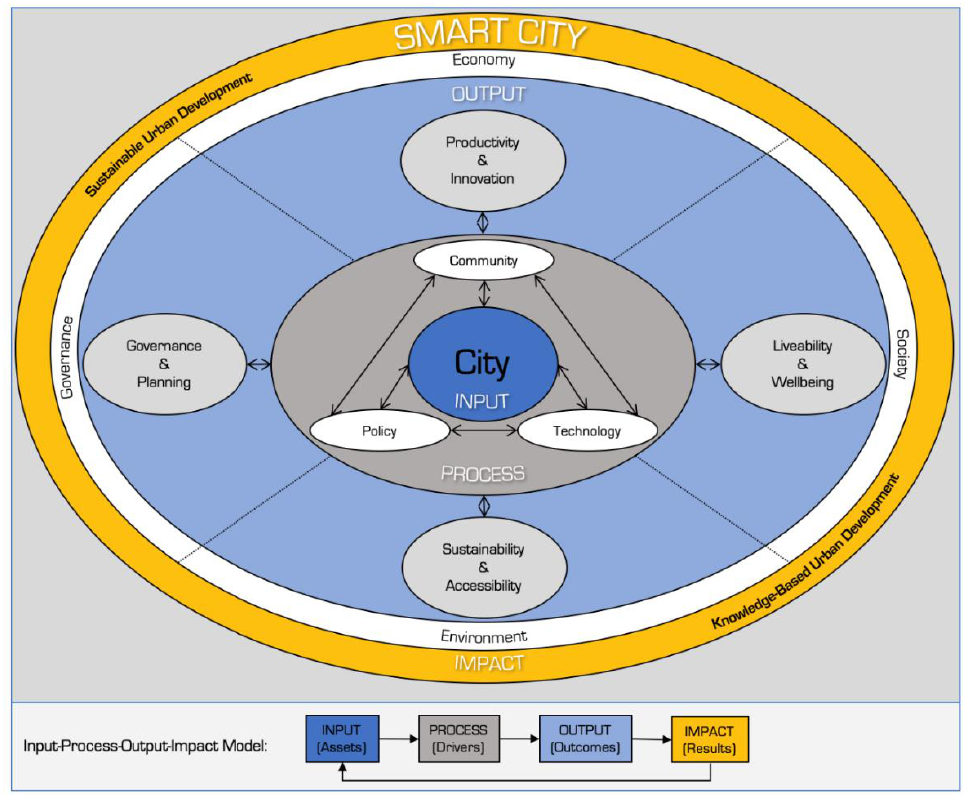
Figure 1. Smart city conceptual framework (derived from [13]).